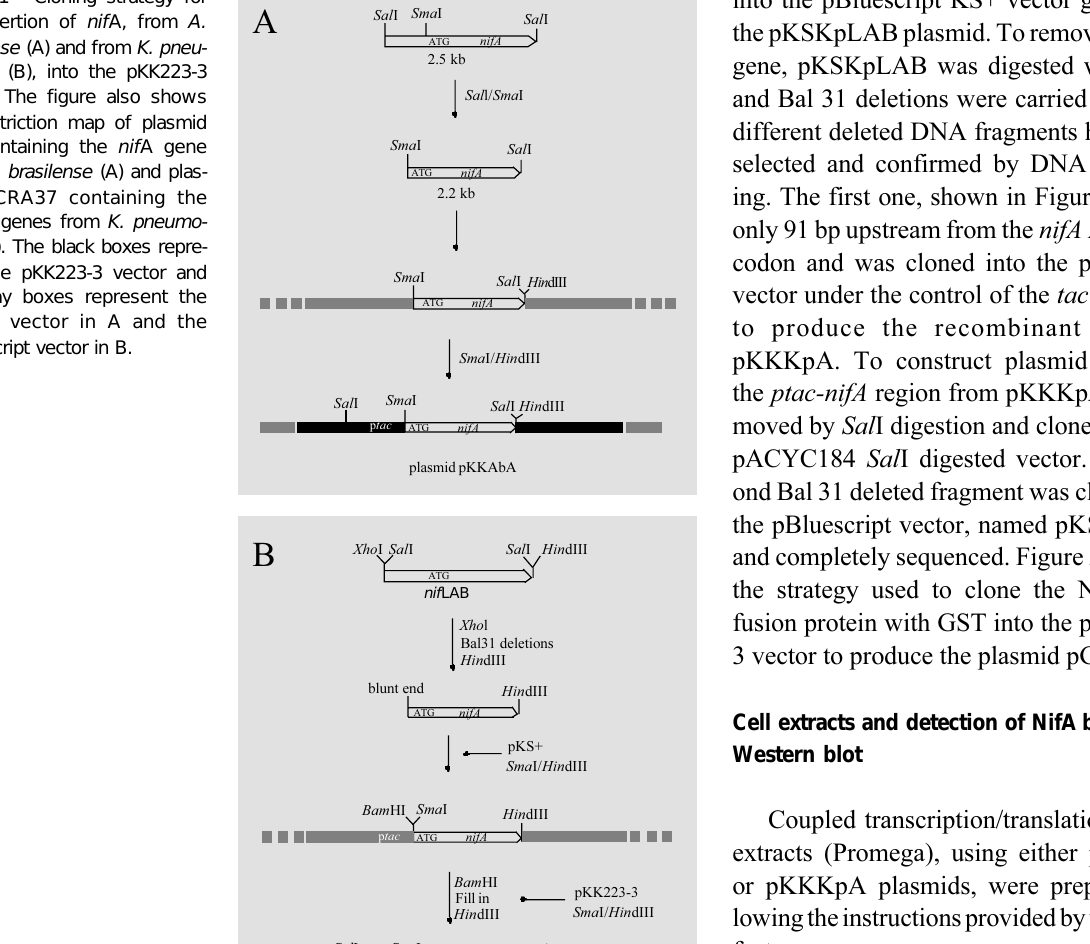
Figure 1 - Cloning strategy for the insertion of nif A, from A. brasilense (A) and from K. pneu- moniae (B), into the pKK223-3 vector. The figure also shows the restriction map of plasmid p10 containing the nif A gene from A. brasilense (A) and plas- mid pCRA37 containing the nif LAB genes from K. pneumo- niae (B). The black boxes repre- sent the pKK223-3 vector and the gray boxes represent the pUC18 vector in A and the pBluescript vector in